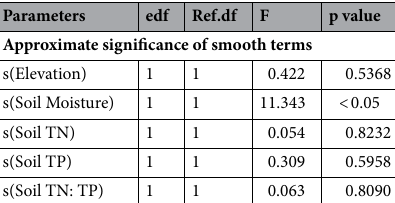
Table 2. General additive model for Phragmites spp . to observe correlation among parameters. R-sq. (adj) = 0.897 Deviance explained = 94%. GCV = 8.8054 Scale est. = 4.7414.